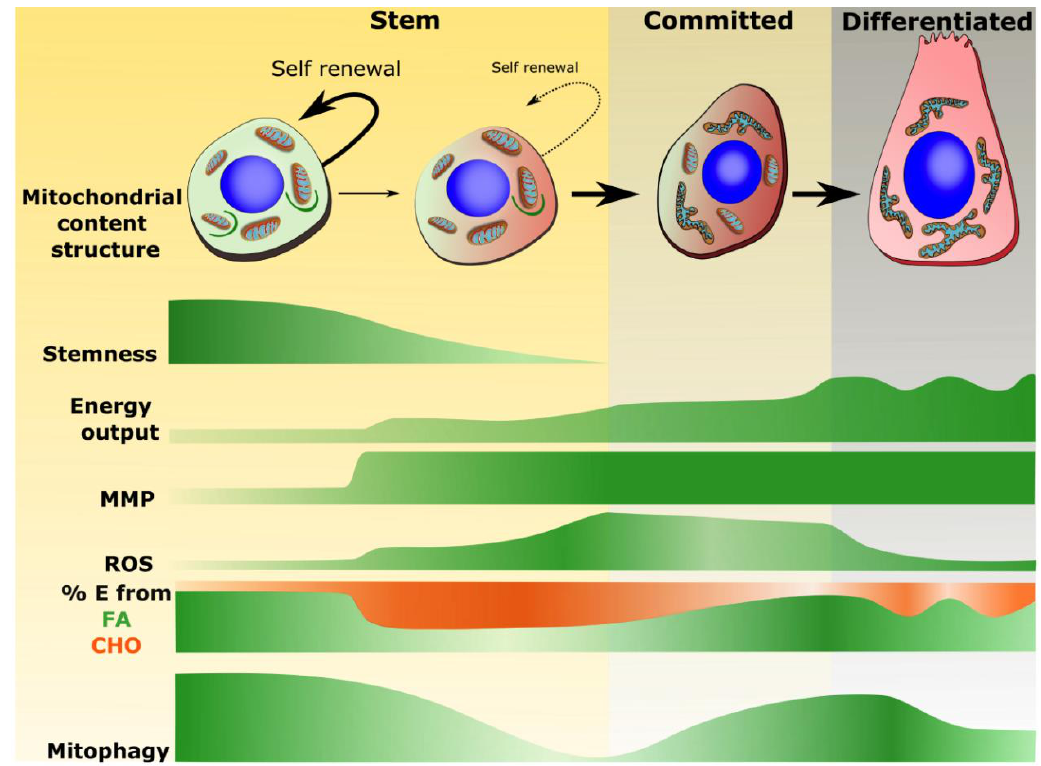
Figure 2. Integrative view illustrating the plasticity of the mitochondrial, metabolic and mitophagy landscape during stem cell lineage progression . Stem cells, although reliant on oxidative phosphorylation (OXPHOS) and fatty acid oxidation (FAO), display low energy outputs in the quiescent state. Hence, mitochondrial content, network complexity, and number of cristae folds is reduced. This low metabolic state is associated with a low mitochondrial electrochemical gradient, often equated to low Mitochondrial Membrane Potential (MMP), and reduced release of Reactive Oxygen Species (ROS). Heterogeneity exists within a stem cell population, with only a fraction presenting high stemness properties [58,69,70]. This latter population, representing the bona fide stem cells ensuring long-term maintenance of potency, present comparatively low rates of cell division and several features of metabolic stemness including low MMP, low ROS emission and increased reliance of FAO [53,58]. In contrast, stem cells harboring more active mitochondria, as evidenced by elevated MMP, increased oxygen consumption, and de-repression of OXPHOS from pyruvate (e.g., carbohydrates) present lower stemness properties, and are more prone to commit in response to activation signals [58]. Increased mitochondrial ROS, and potentially other metabolic cues, are suggested to act as signaling factors involved in the commitment of stem cells [53,68]. Once committed stem cells undergo highly orchestrated and lineage-specific mitochondrial remodeling programs which are required for normal di ff erentiation. For instance, progenitors destined to di ff erentiate into cells with high and / or sustained energy requirements, remodeling is generally characterized by increased mitochondrial biogenesis and network complexity, qualitative changes in mitochondrial ultrastructure, enhanced OXPHOS capacity, and heightened antioxidant capacity. Mitophagy is believed to be active in quiescent stem cells particularly those displaying the low MMP, low metabolic state [58], suggesting a role in the maintenance of metabolic stemness. Upregulation of mitophagy is also required during cellular di ff erentiation which involves large-scale remodeling of mitochondria, particularly in energy demanding tissues [44]. Furthermore, evidence suggest that downregulation of mitophagy in stem cells promotes commitment. (E, energy; FA, fatty acid; CHO,